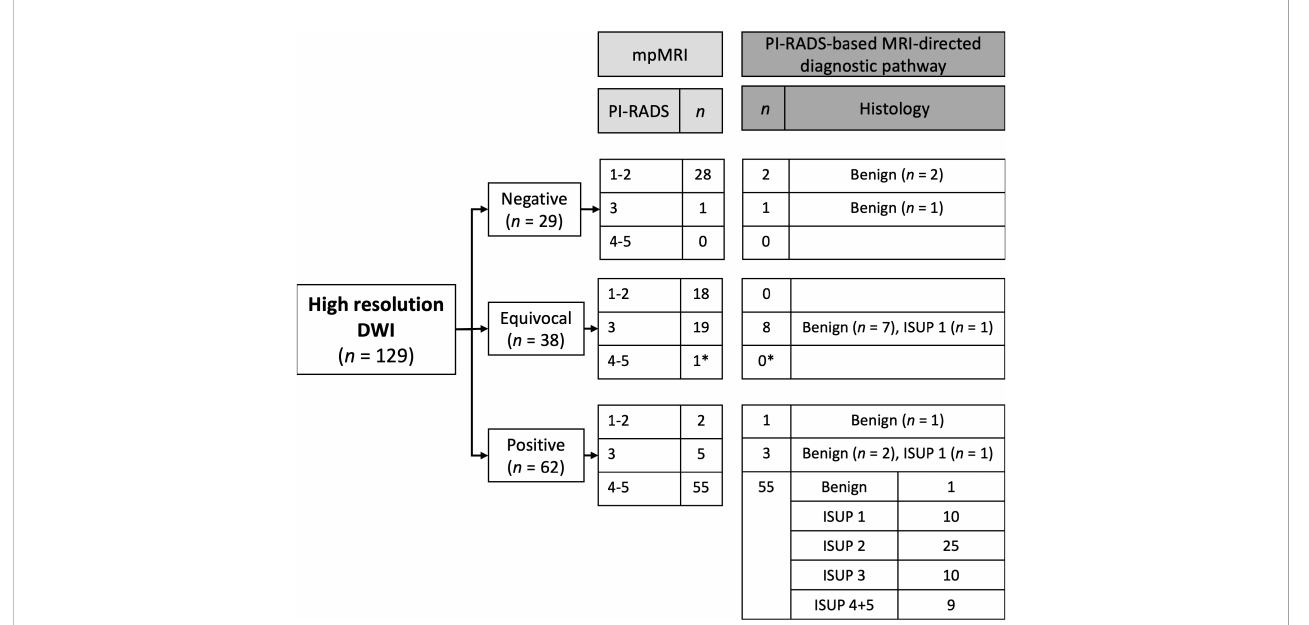
FIGURE 4 Results from the prospective interpretation of high-resolution DWI-only compared to PI-RADS (mpMRI) and biopsy results. *No biopsy performed because of comorbidity and a small lesion at MRI. The patient was referred to PSA monitoring and was not re-referred within the 55 months he was